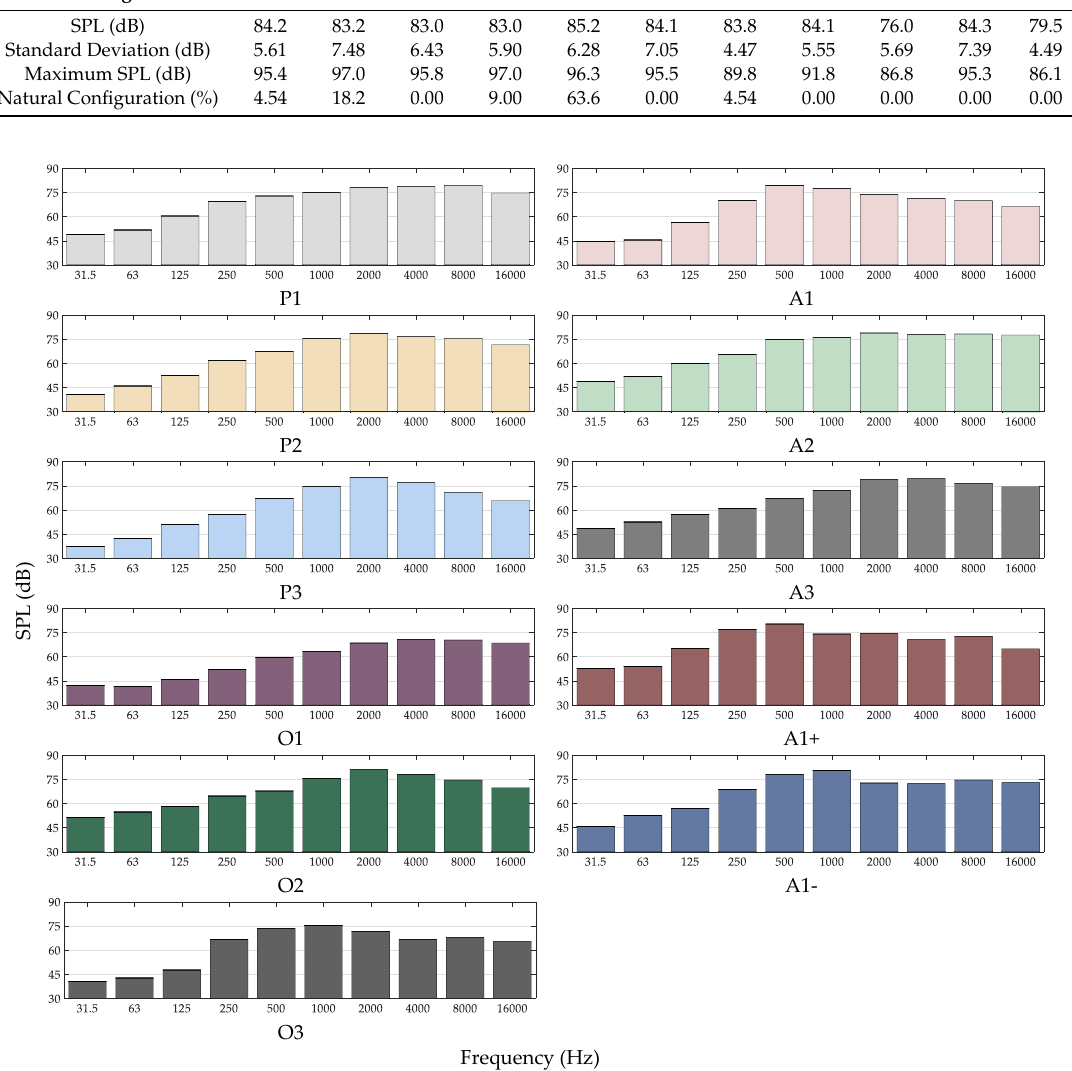
Figure 3. Octave frequency bands for the eleven hand configurations. Subfigures present the octave frequency band for each hand configuration denoted by the abbreviation for each configuration.